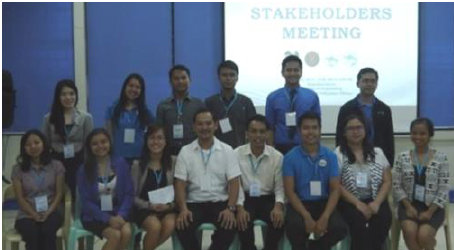
Figure 7. UPD PHD team at the Stakeholders’ Meeting in